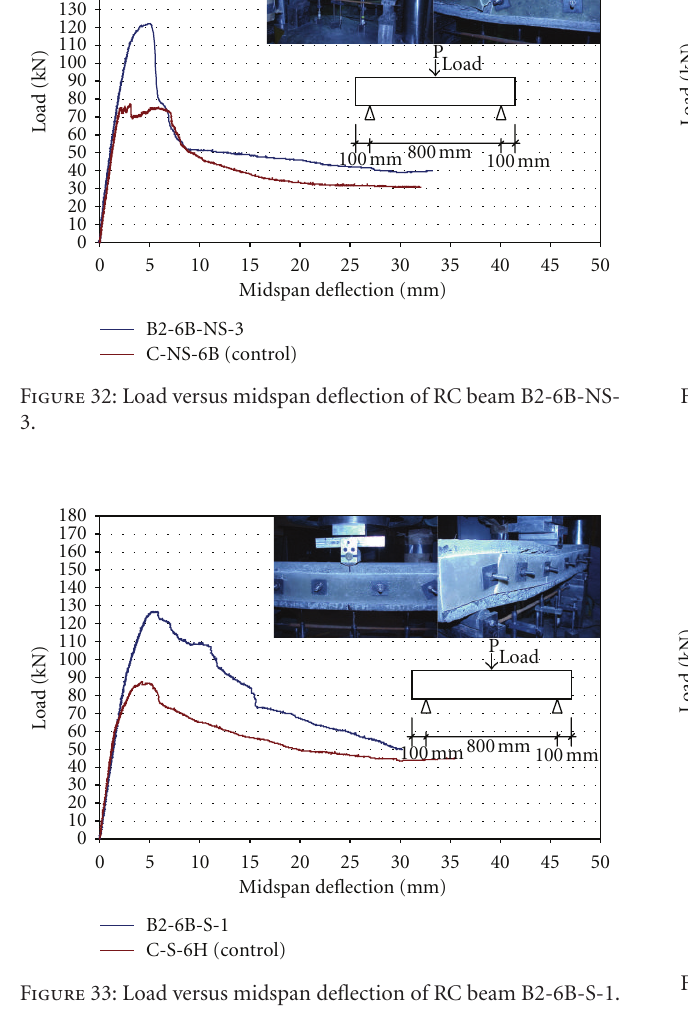
Figure 33: Load versus midspan deflection of RC beam B2-6B-S-1.